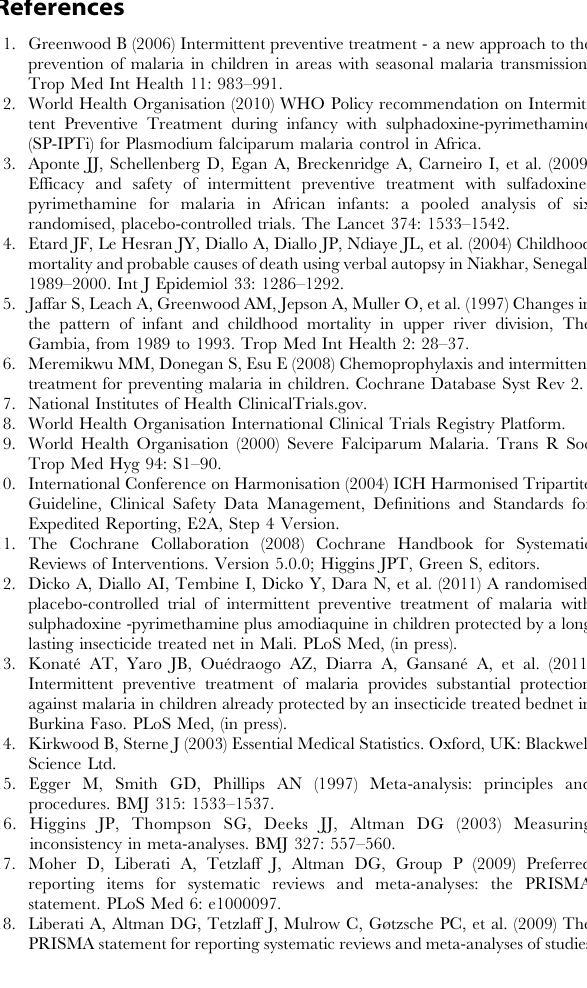
During the Intervention